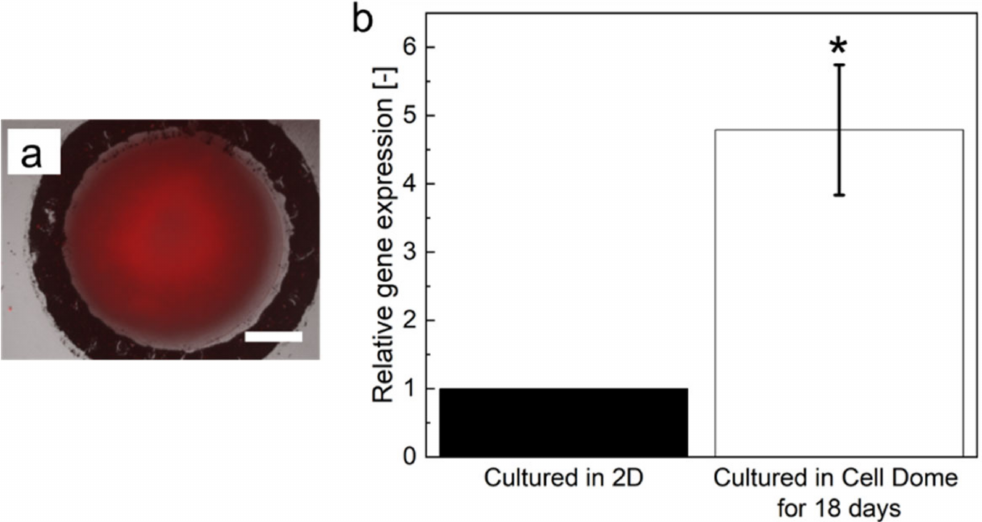
Figure 4. ( a ) Fluorescence observation of HepG2 cells cultured in Cell Domes at 18 days and stained with LOX-1. Bar: 250 µ m. ( b ) HIF-1 α gene expressions in 2D-cultured HepG2 cells on a tissue culture dish and those cultured in Cell Domes for 18 days. Each value was normalized by the means of data in the 2D-cultured cells. Bars: SD, ( n = 3). * p < 0.05 vs. 2D-cultured cells on a tissue culture dish.